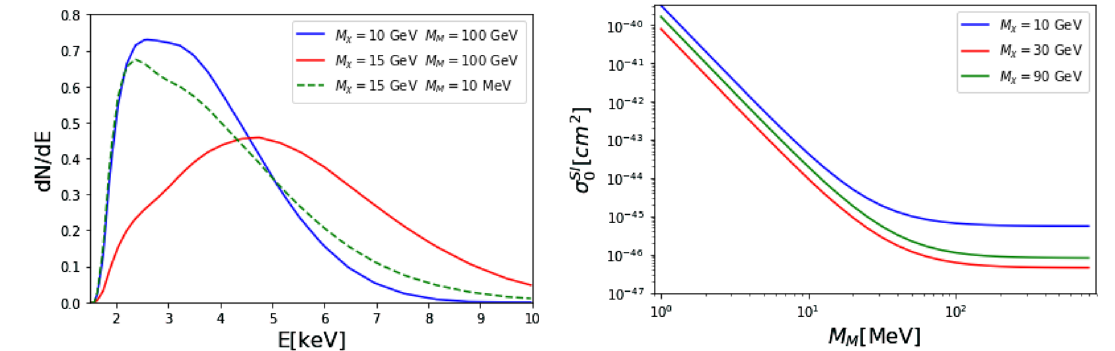
M M = 10 MeV (dash) and M χ = 15 GeV. Right: dependence of the excluded cross section on the mediator mass for M χ = 10 , 30 , 90